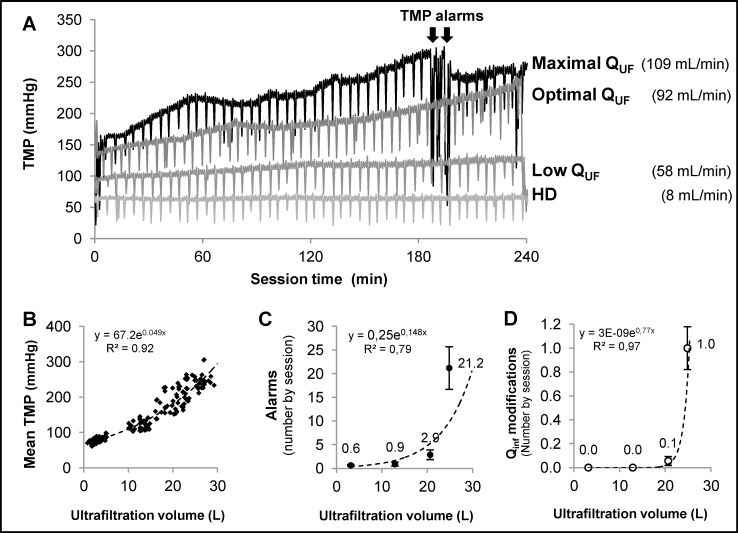
Panel A) Example of TMP variations during dialysis, for one patient with the four different convection volumes prescribed as to the protocol. TMP remained stable in haemodialysis and in low convection HDF while it increased during the treatment with optimal and maximum convection HDF. In the latter the increase was steeper and resulted in the appearance of TMP alarms that motivated nursing staff interventions. Panel B) depicts the TMP over convection volume function: each point represents the average of ~400 measurements during every dialysis of the 141 dialysis studied using a XEVONTA 1.8 m2, totaling >56,000 TMP measurements. Panel C) plots the number of alarms recorded during the assessed treatments and shows that it was around x10 fold in maximum when compared to optimal convection treatments. Panel D) plots the number of reductions in infusion flow necessary to avoid the alarms and pursue the treatment for the 4 treatment types, showing that infusion reduction was almost constantly required in maximum convection HDF at least in one occasion (a mean of 1 per session).